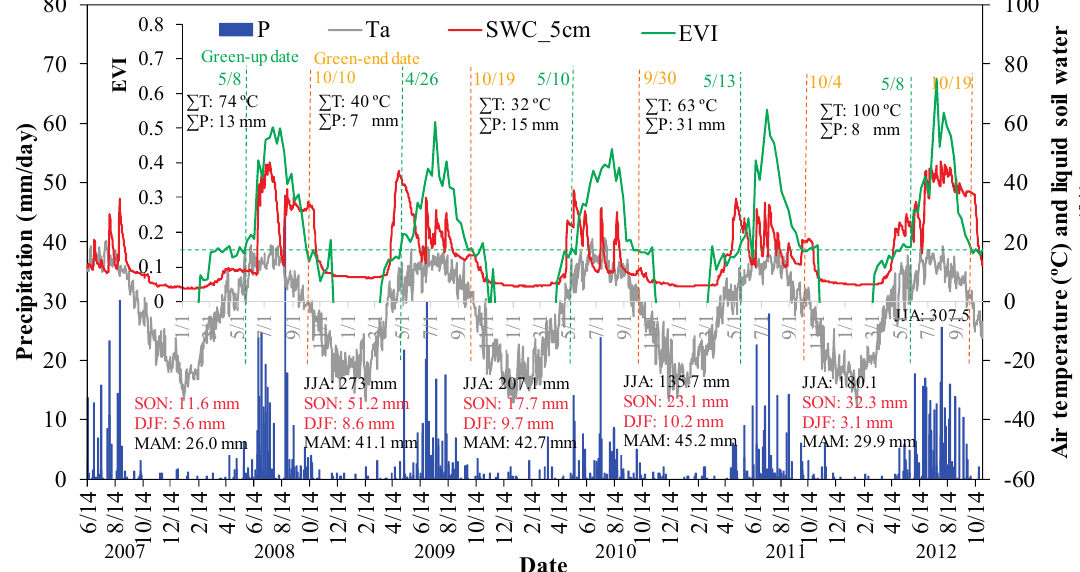
Figure 8. Seasonal patterns of daily rainfall (P), mean air temperature (Ta), volumetric liquid soil water content (SWC) at the 5 cm depth, and EVI at the Davaat site from 2007 to 2012. ∑ T and ∑ P are cumulative > 0 °C air temperature and cumulative precipitation before SOS in